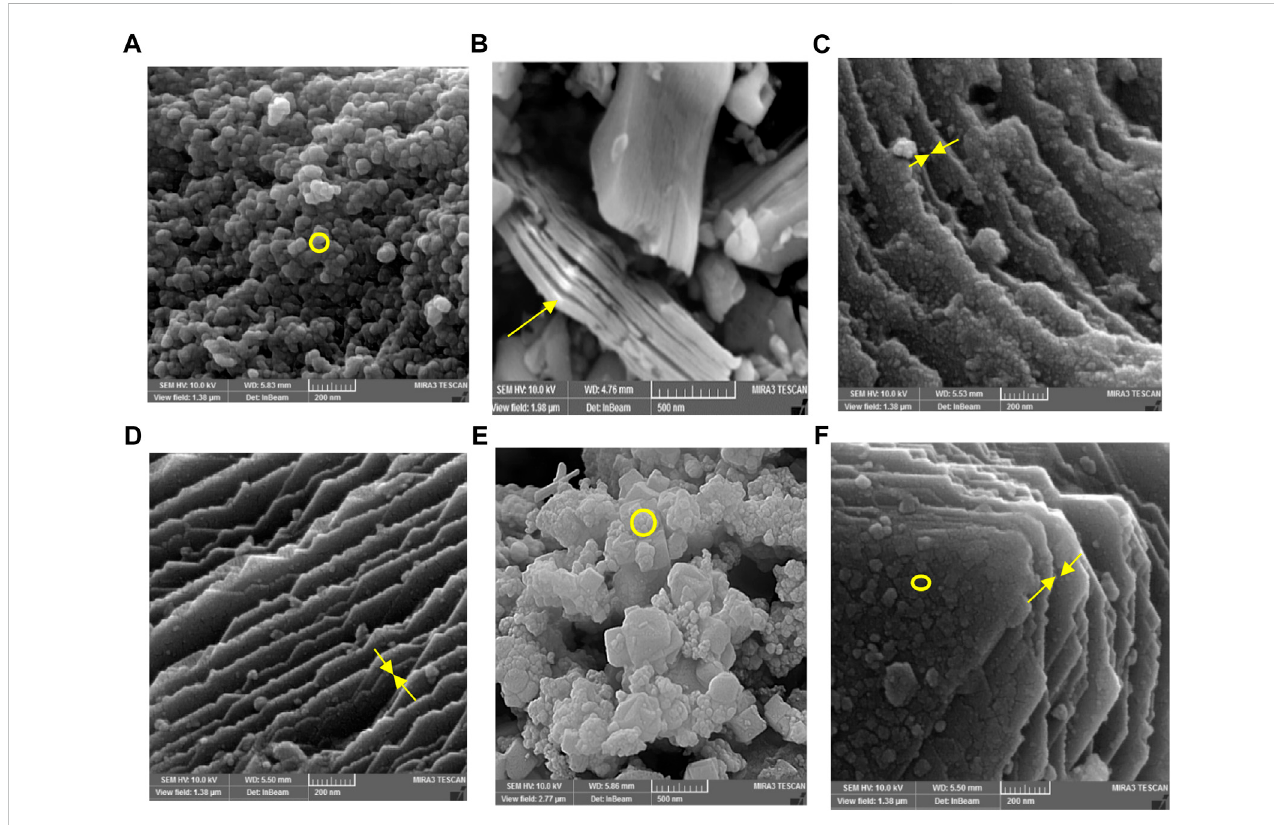
FIGURE 2 FESEM analysis of (A) Fe 3 O 4 @SiO 2 , (B) MAX phase, (C) Ti 3 C 2 -Fe 3 O 4 @SiO 2 -FA, (D) Ti 3 C 2 @FA, and (E) Ti 3 C 2 -Fe 3 O 4 @SiO 2 -FA-Cisplatin, and (F) Ti 3 C 2 @FA- Cisplatin.